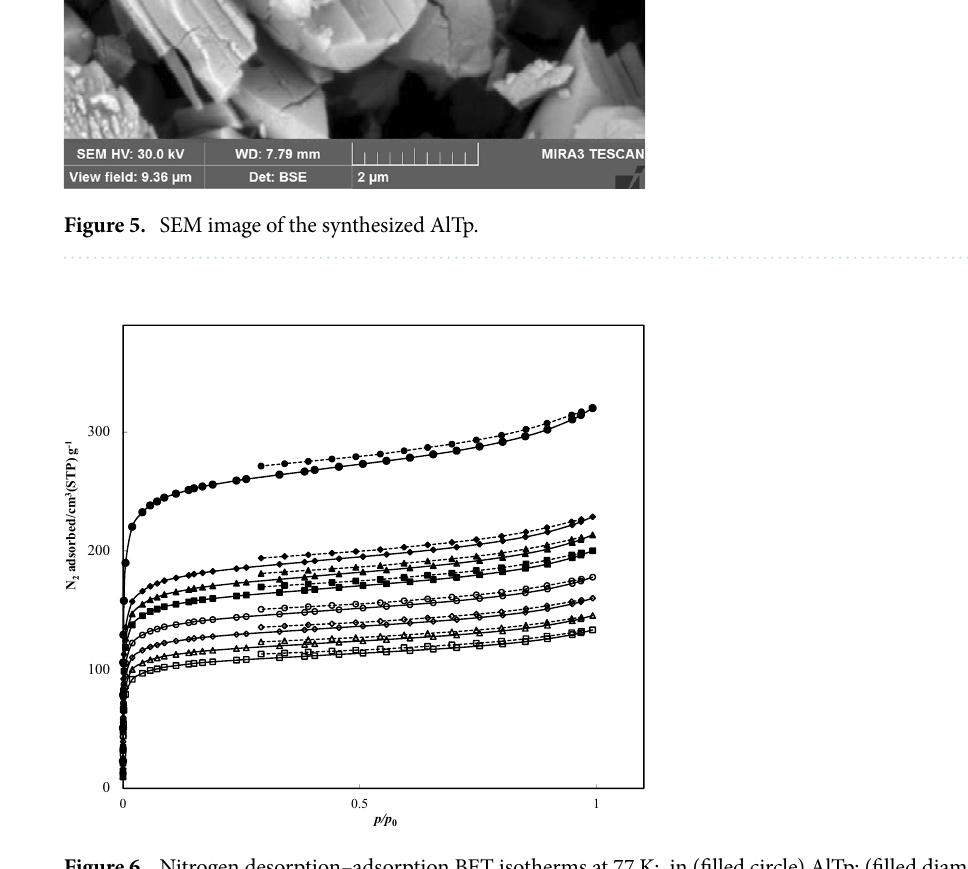
Figure 6. Nitrogen desorption–adsorption BET isotherms at 77 K: in (filled circle) AlTp; (filled diamond) [BMIm][Cl]/AlTp; (filled triangle)[BMIm][Br]/AlTp; (filled square)[BMIm][SCN]/AlTp; (open circle)[BMPyr] [Cl]/AlTp; (open diamond)[BMPyr][Br]/AlTp; (open triangle) [BMPyr][SCN]/AlTp; and (open square)